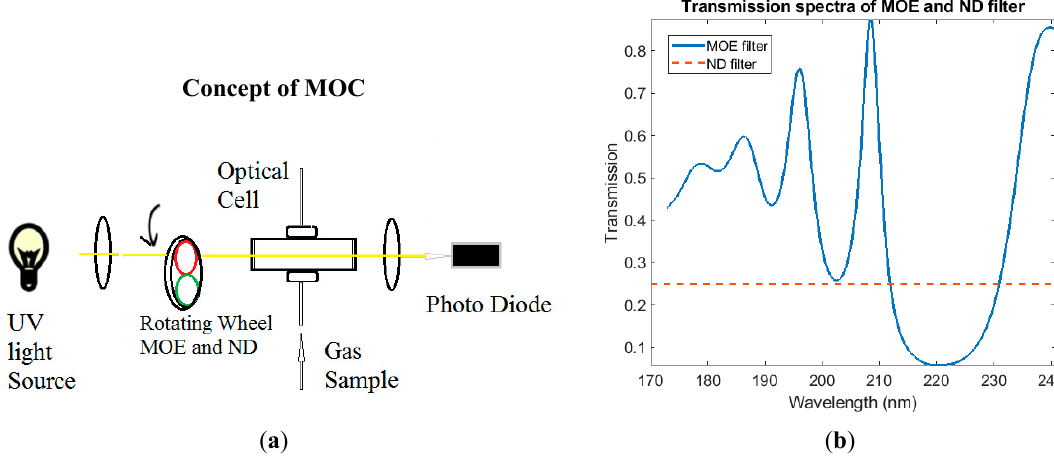
Figure 1. ( a ) The schematic concept of MOC sensor; ( b ) example transmission spectra of MOE and ND filter.